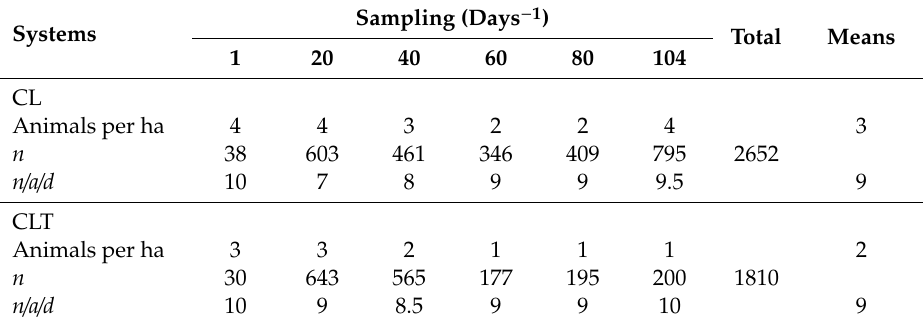
Table 3. Number of cattle maintained per system, in each cattle dung sampling (1, 20, 40, 60, 80 and 104 days, after grazing commenced). Total amount of excreta per livestock unit ( n